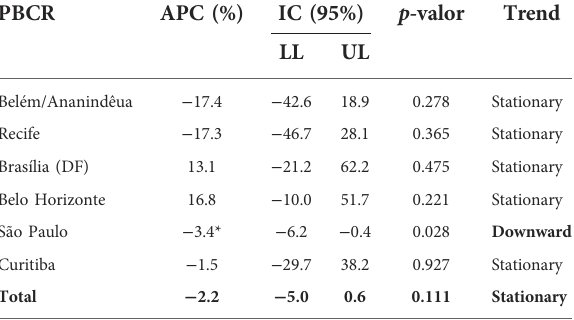
TABLE 5 Retinoblastoma mortality trends between 0 and 19 years of age, in six Brazilian cities, from 2000 to 2014, National Cancer Institute, Ministry of Health, Brazil.